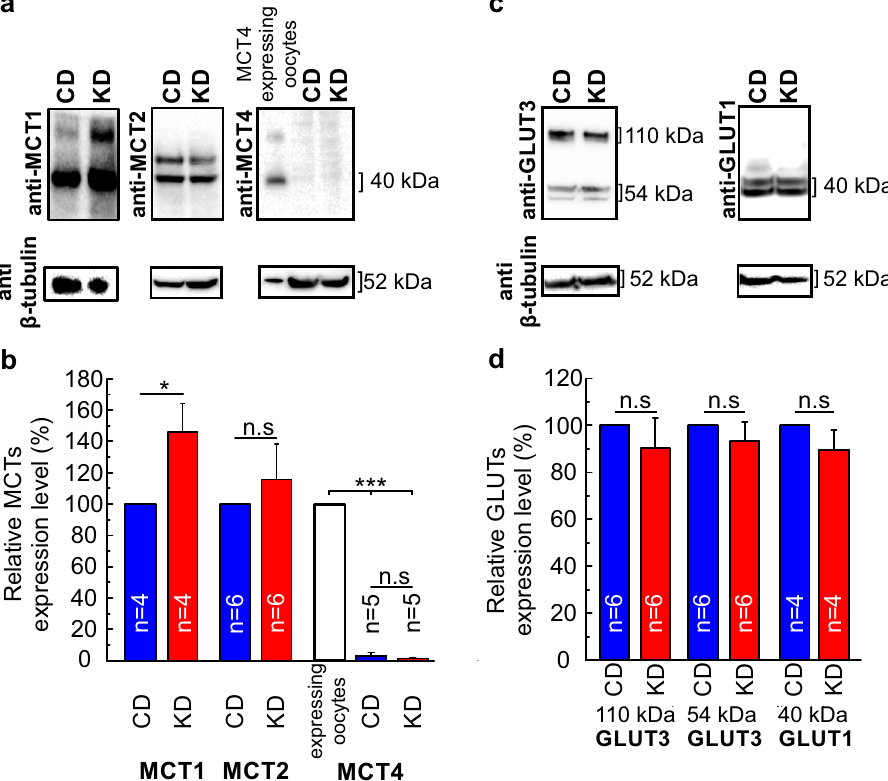
Figure 4. Ketogenic diet increases MCT1 expression level in mouse brain cortex. Western blot analysis in cortex from mice fed with control (CD) and ketogenic diet (KD) against MCT1, MCT2 and MCT4 ( a ), and GLUT3 and GLUT1 ( b ), β -tubulin is shown as loading control in each blot. The blots were cropped for better clarity. The full-length blots are shown in Fig. S4. Quantification of the relative expression levels for MCT ( c ) and GLUT ( d ) proteins. Results were normalized to the CD protein concentration on the same blot or to the concentration of MCT4 obtained for MCT4-expressing oocytes (only for MCT4). Statistical values are presented as means ± S.E.M and significance was tested with a paired Student’s t-test. Number of mice used are indicated in the bar